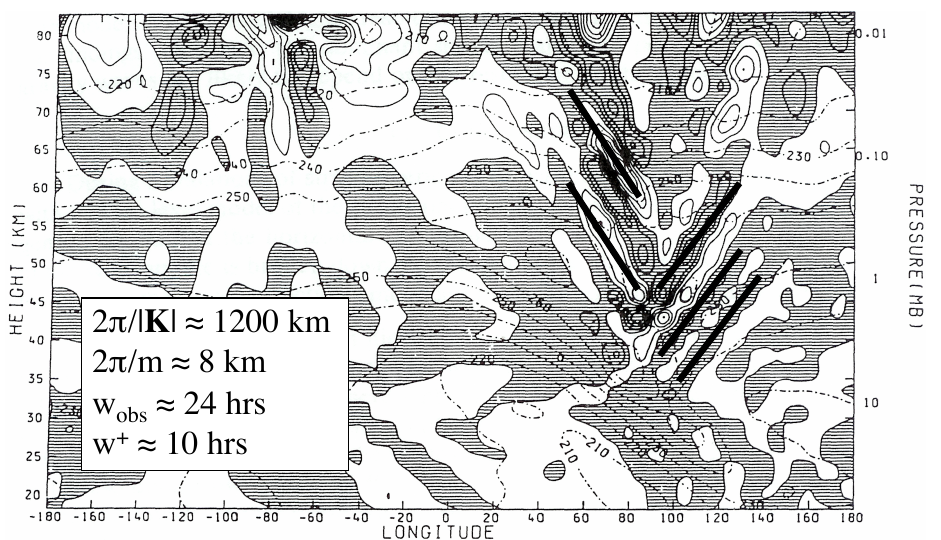
Fig. 1. From Fairlie et al. (1990). Simulated cross-section of temperature (dashed, units of K) and the divergence of the horizontal wind (solid, units of 10 − 6 s − 1 ) at 57.5 ◦ N on 25 February 1979. Regions of convergence are shaded. Note that the the original pressure axis of millibars (written as mB) has been retained. The figure has been modified to highlight modeled, upwardly propagating gravity waves to both the west and east of the STE/baroclinic zone. Estimated gravity wave parameters are